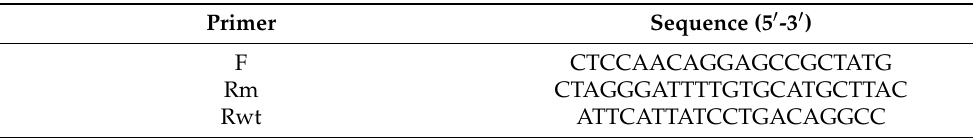
Figure 1. Exon 1 and 2 deletion in the parla gene by CRISPR/Cas9-mediated mutagenesis. ( A ) Schematic representation of sgRNA targeting and deletion of parla exons 1 and 2. The two sgRNAs that contributed to the deletion are shown. Exons are represented with blue cylinders and introns with black lines between the exons. The dashed line represents the 5 ′ UTR region. Primers used in genotyping are represented by F (forward primer), Rwt (reverse primer for the WT), and Rm (reverse primer for the mutant). ( B ) Agarose gel showing WT band (500 bp) and mutant band (350 bp). The marker used is a 10 kb DNA ladder mix (GeneRuler TM ). +/+ refers to WT. +/ − and − / − refer to heterozygous and homozygous mutants, respectively. Table 2. List of primers designed for PCR amplification.